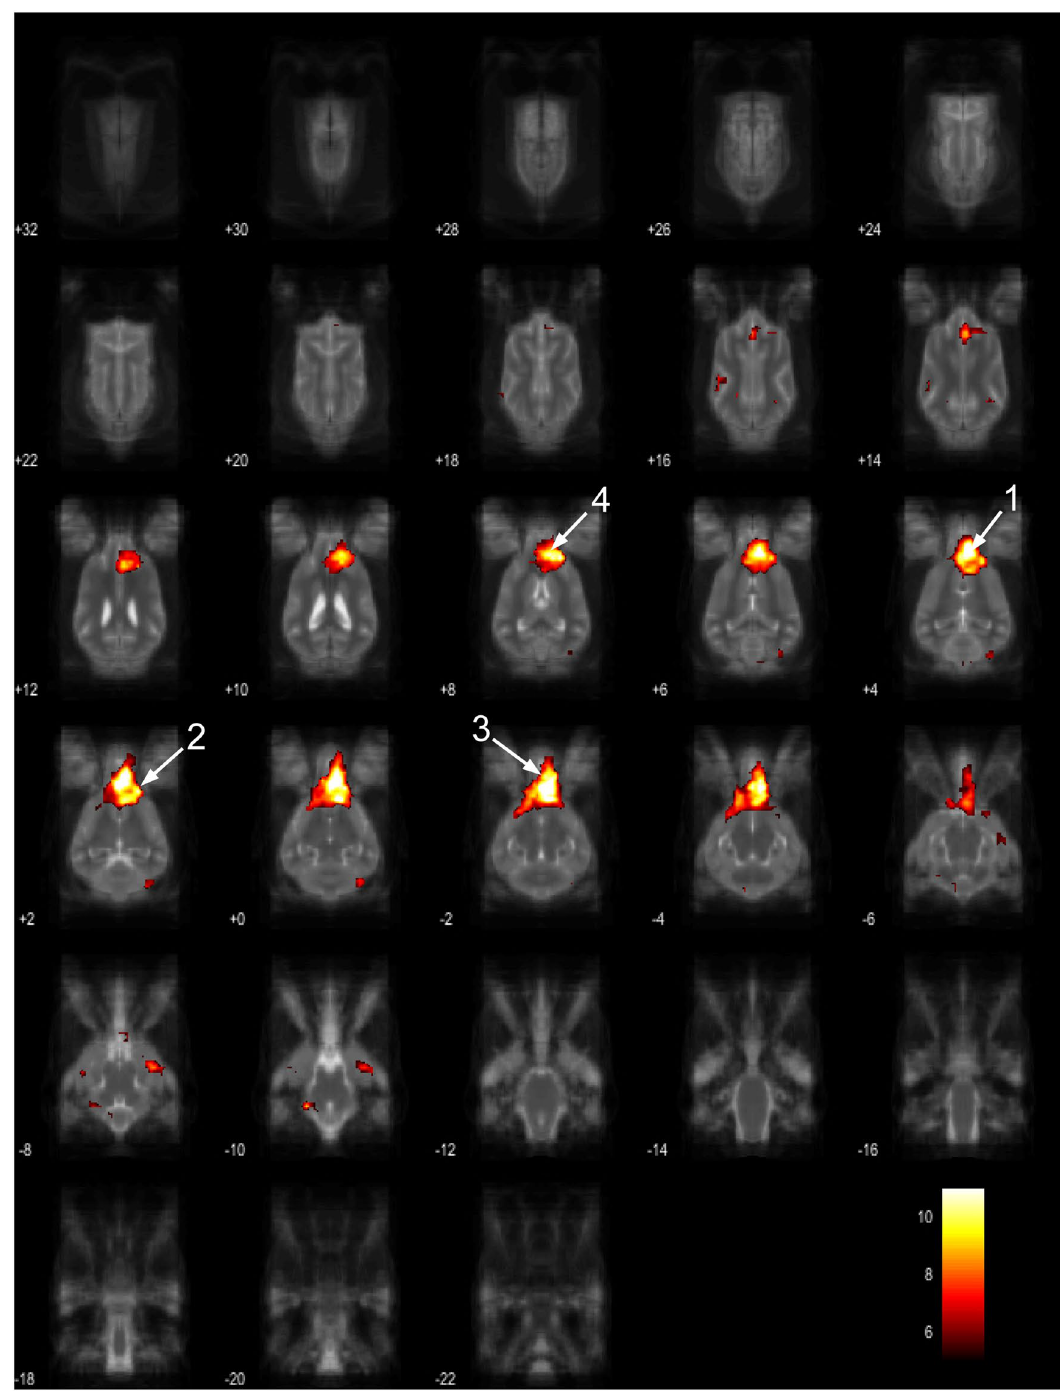
Figure 5. Resting-state network component B from the 15 component gICA. We report the results with a voxel- wise FDR corrected p < 0.001 and cluster treshold of FDR corrected p < 0.005. gICA components are presented as thresholded T-maps, corrected for multiple comparisons, overlaid on the Nitzsche atlas 15 . 1. genual gyrus, 2. prorean gyrus, 3. straight gyrus, 4. dorsal anterior cingulate